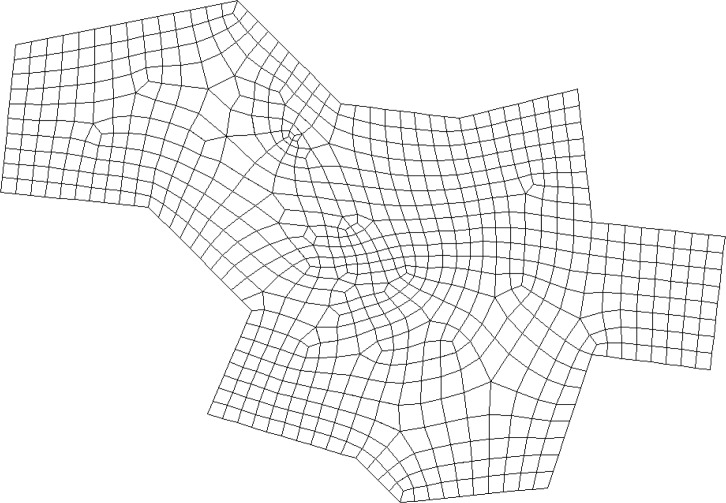
An example of CQ.